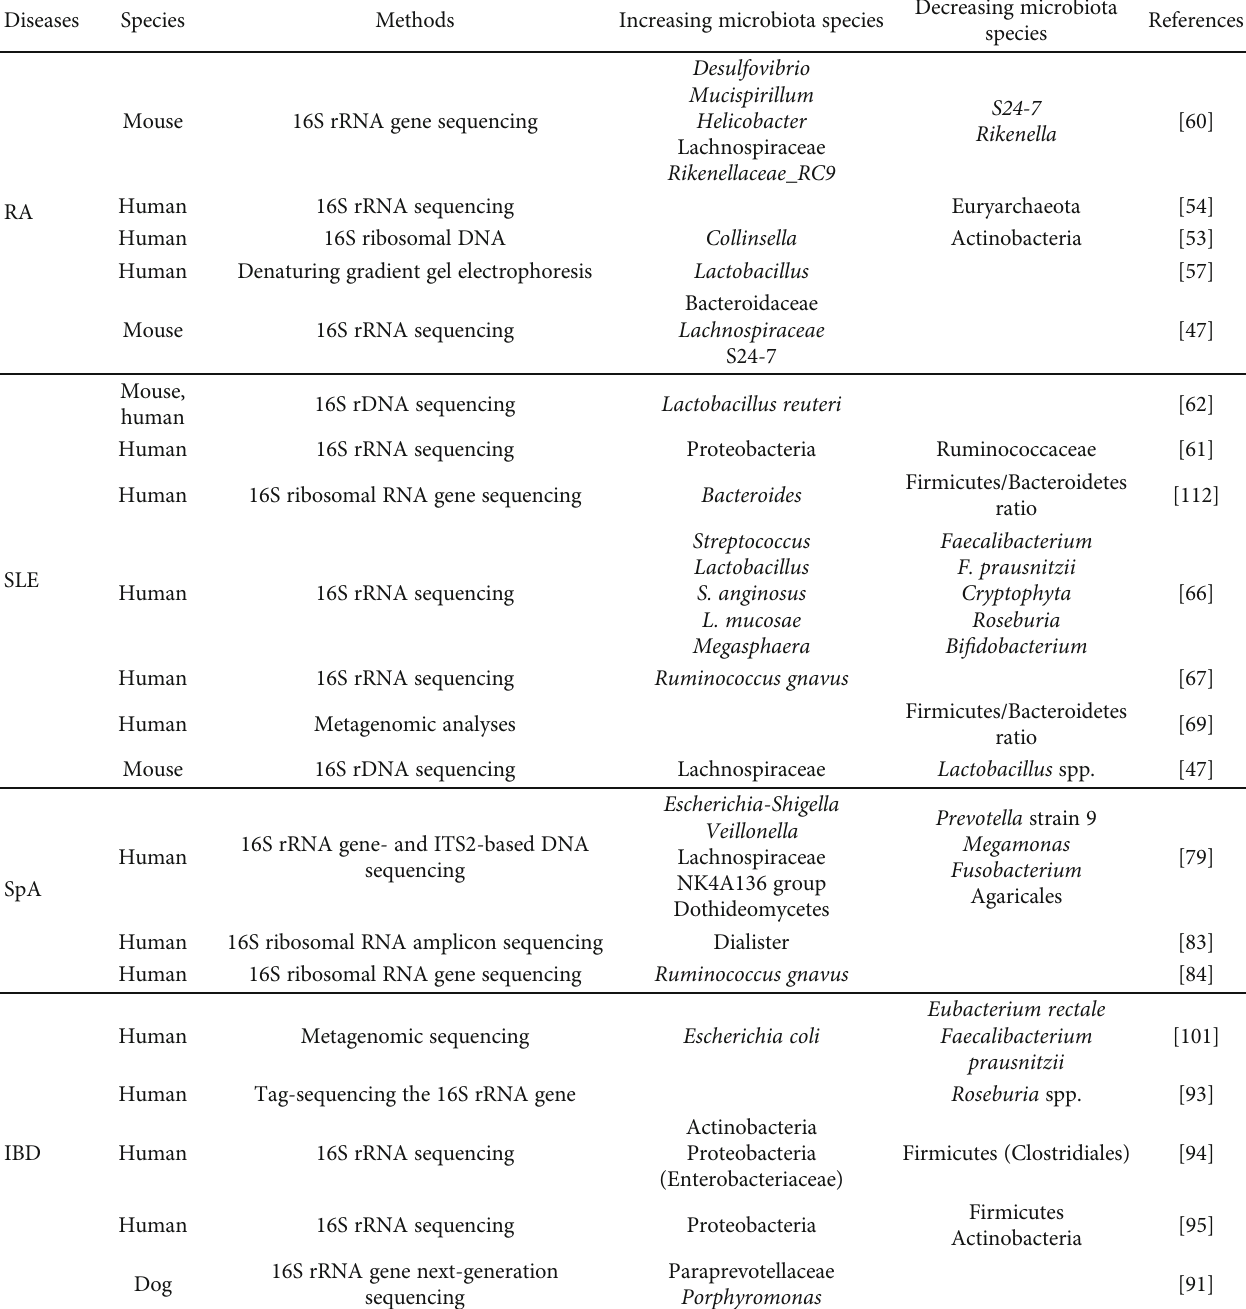
Table 1: Autoimmune diseases and alteration of the gut microbiota